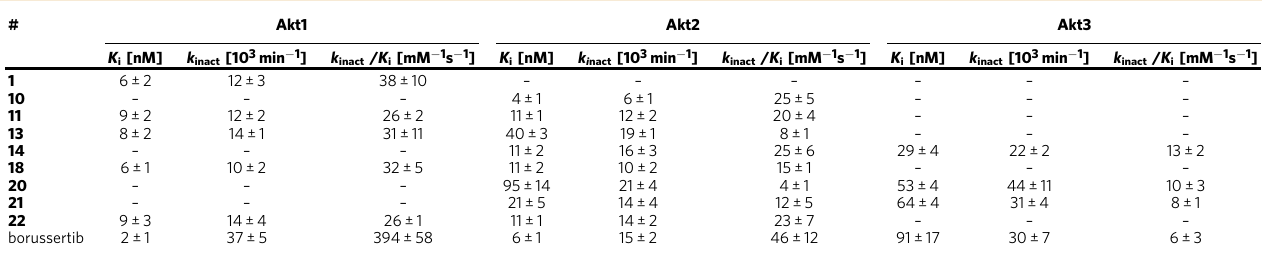
Table 2 Kinetic evaluation of covalent-allosteric Akt ligands with the three Akt isoforms. #